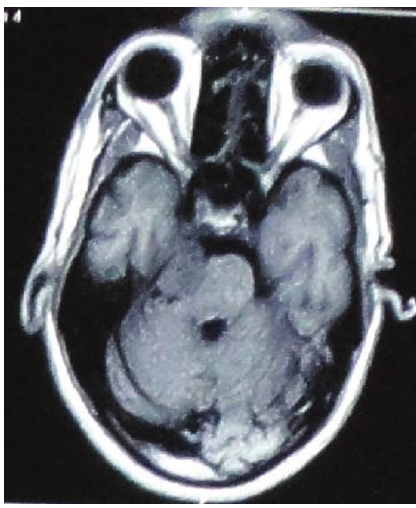
Figure 1: Axial view of T1W image showing isointense, well-defined lesion seen in right cerebellopontine angle causing rotation of brain stem and compression of contralateral CP